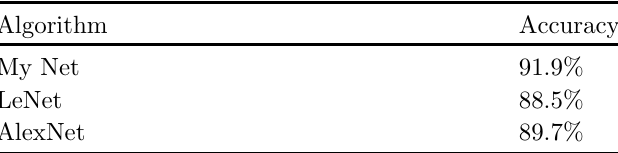
Table 5. The classi fi cation accuracy of different networks for test